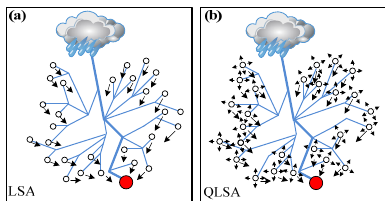
Figure 1. Movements of step leaders in ( a ) the lightning search algorithm (LSA) and ( b ) the quantum ‐ behaved LSA (QLSA).